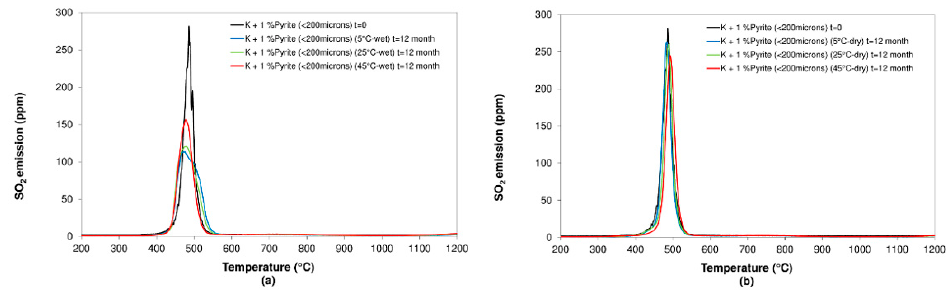
Figure 10. Evolution of sulfur dioxide emission of the coarser fraction of the pyrite composition in ( a ) a wet environment and ( b ) a dry environment .